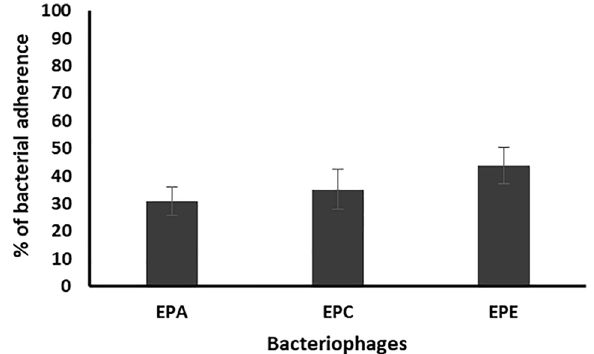
Figure 7. Percentage of bacterial adherence on the surface of catheters segments of 3 enterococcal isolates (EF104, EF134, and EF151), prepared in dilution 1/500 from bacterial suspension adjusted to 0.5 MacFarland, in the presence of the three bacteriophages (EPA, EPC, EPE) as compared to the control. Each bar represents the mean of three independent measurements.